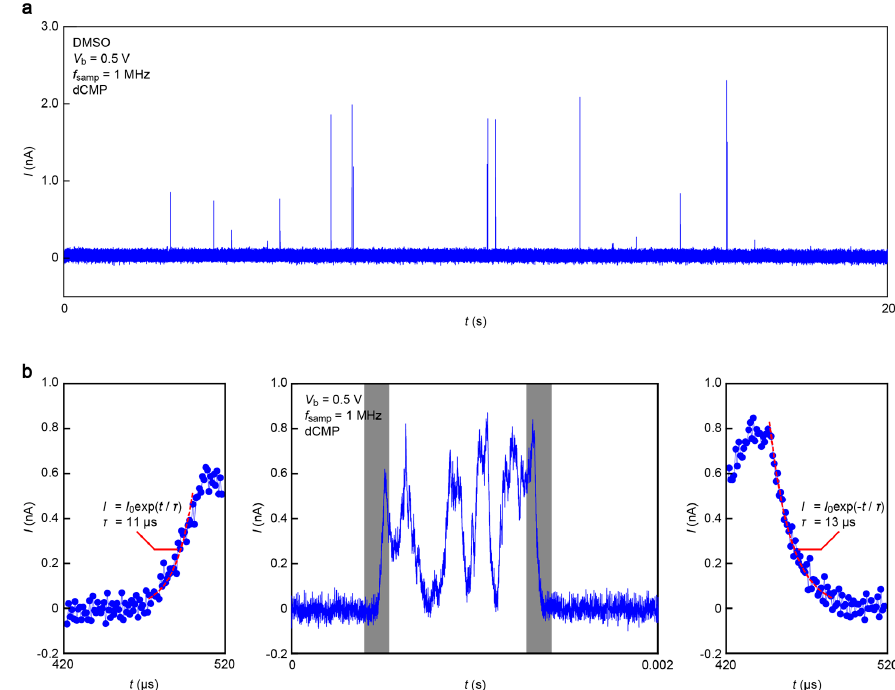
Figure 5. ( a ) Current versus time trace recorded in a DMSO solution of dCMP using a 1 nm ‐ sized SiO 2 ‐ protected Au electrode gap at a 1 MHz sampling rate with a 1 MHz low ‐ pass filter under the applied voltage V b of 0.5 V. Pulse ‐ like signals were observed, signifying trapping/detrapping of single ‐ molecule dCMP between the nanoprobes; ( b ) Magnified views of a tunneling current spike. Grey regions in the middle panel indicates the rising (left) and falling (right) of the signal. Red dashed lines represent the exponential fit.